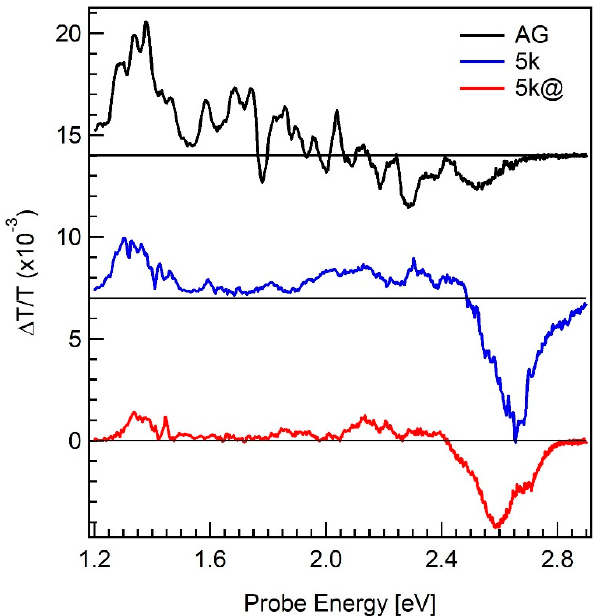
Figure 5. Transient transmittivity Δ T/T (E, t = 5 ps) curves at long dynamics collected on the AG (black), the 5k (blue) and the 5k@ (red) samples. All the measurements are performed with a pump photon energy of 3.27 eV and with an excitation fluence of 3.5 mJ/cm 2 . Both pump and probe pulses are linear polarized and mutually parallel.